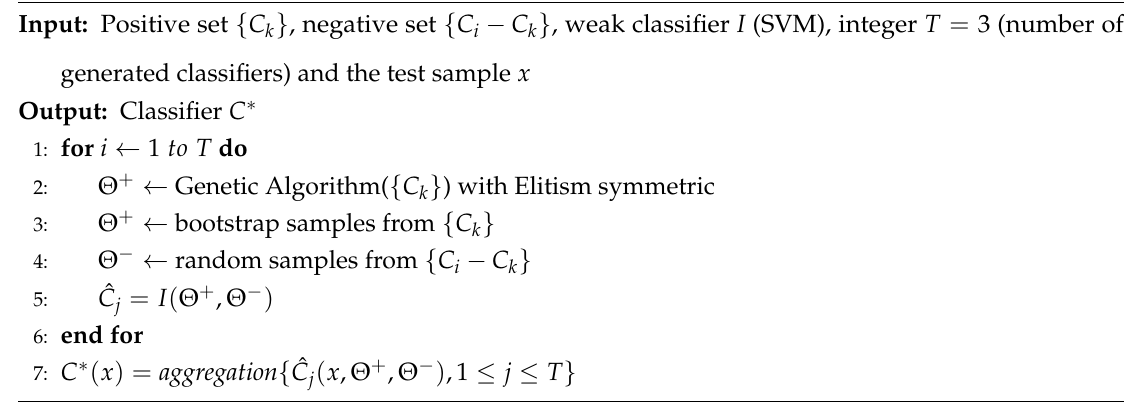
Algorithm 3 Bagging based on tournament selection through GA for